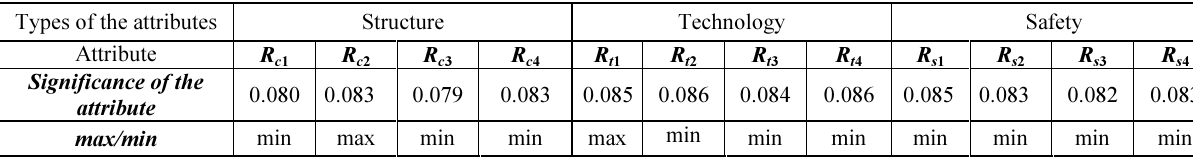
Table 9. The rationality of the external wall alternatives ac- cording to technological, structural and work safety attributes using the significance of attributes deter- mined by the expert method Rationality